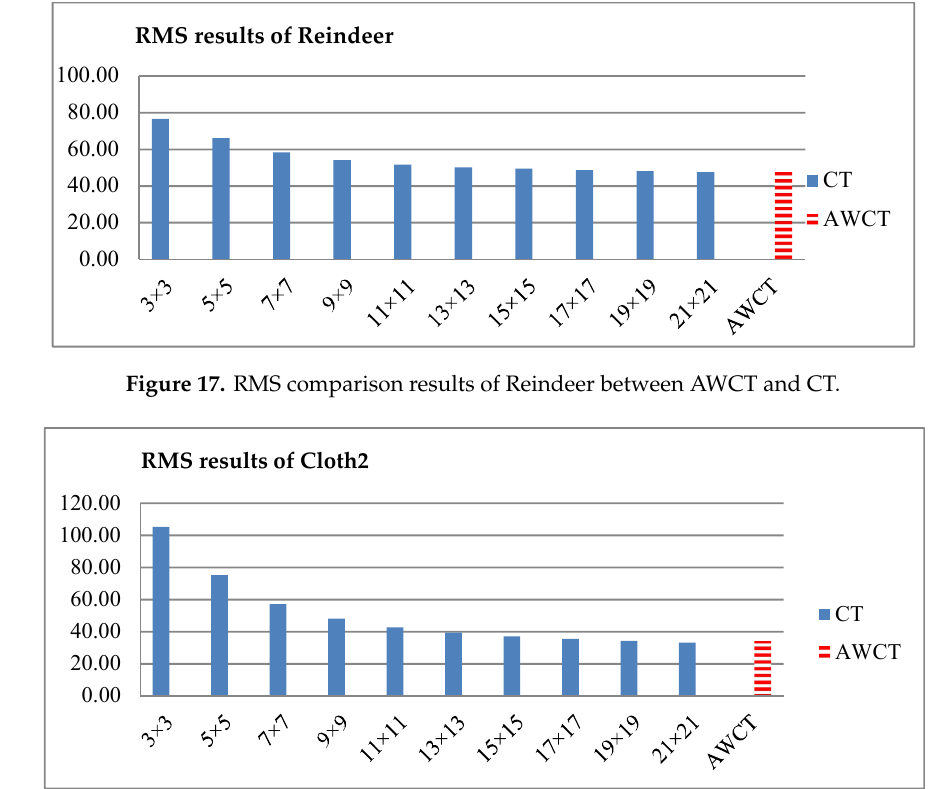
( f ) Figure 14. The results of Baby1 by AWCT. ( a ) Edge information and schematic diagrams of the biggest window size in ( b ) 13 × 13, ( c ) 15 × 15, ( d ) 17 × 17, ( e ) 19 × 19, and ( f ) 21 × 21. Figure 15. RMS comparison results of Moebius between AWCT and CT.